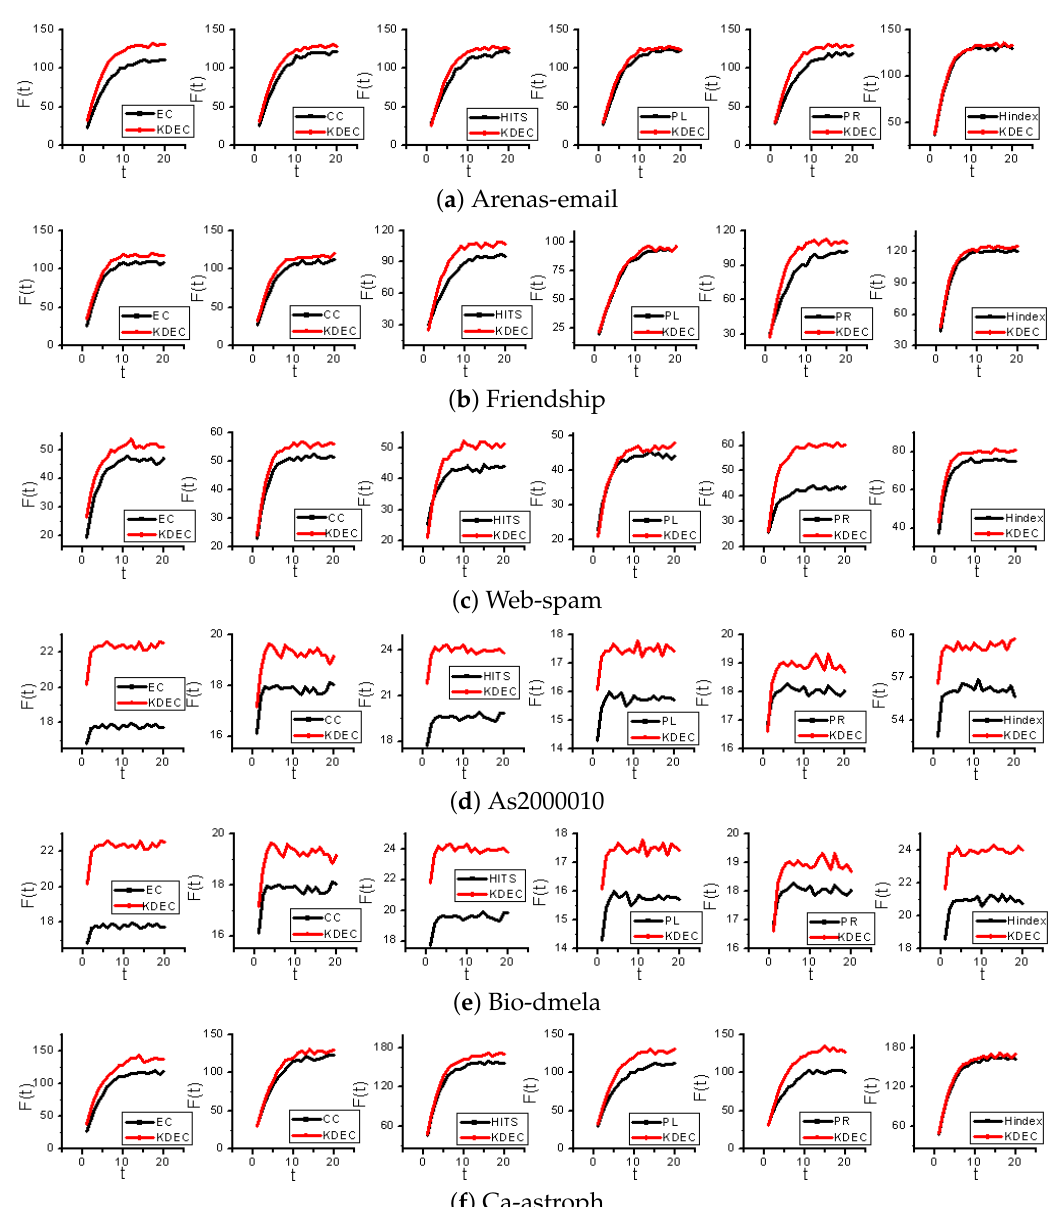
Figure 3. Propagation effects of the top-10 different nodes of KDEC and other comparison